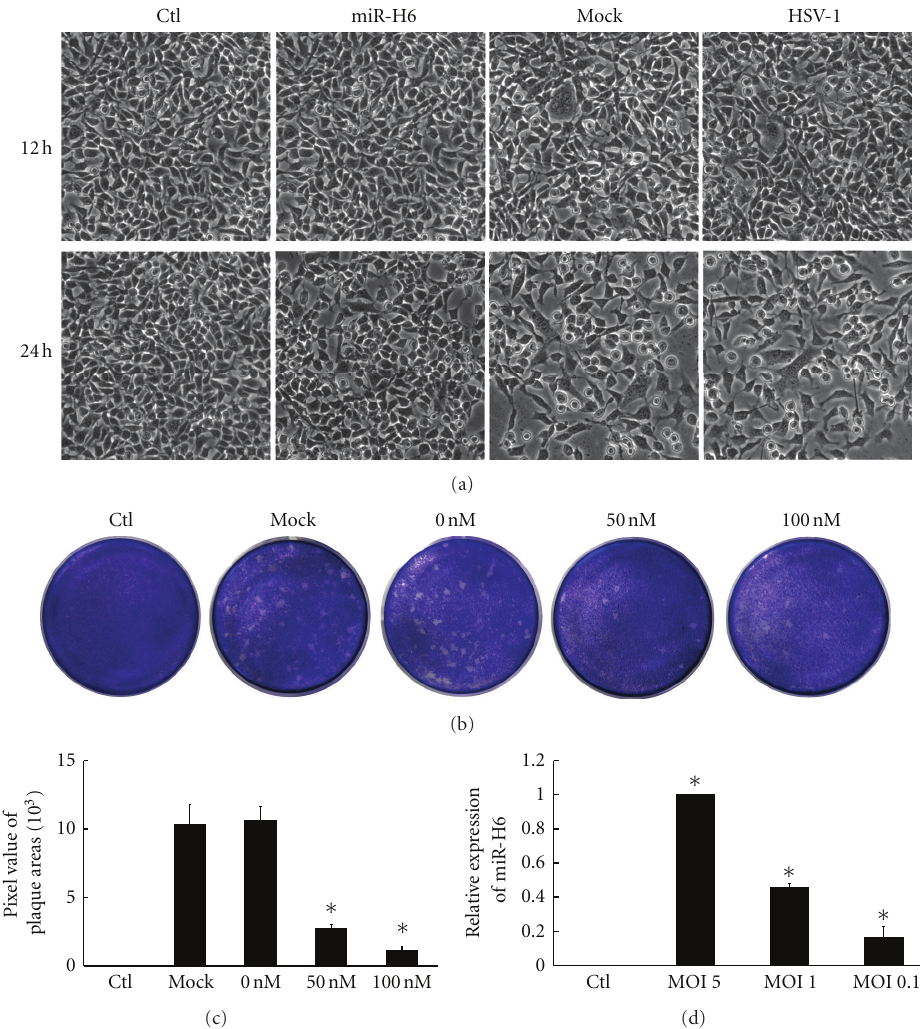
Figure 1: miR-H6 e ff ects on cell changes and viral replication in HSV-1-infected HCE cells. HCE cells were transfected miR-H6 mimics and mock, followed by infection with MOI 0.1 of HSV-1 24 h posttransfection. (a) The cellular morphological changes were imaged at 12 h and 24h postinfection. CPE clearly increased, and many multinucleated giant cells could be seen in the cells treated with mock RNA and cells untreated with small RNA; fewer CPE and giant multinucleated cells could be seen in cells transfected with miR-H6 mimics. (b, c) Plaque assay showed that treatment with miR-H6 decreased the plaque sizes and numbers and had a statistically significant di ff erence ( P < 0 . 05). Cells were treated with miR-H6 mimics (0, 50, 100nM) and mock RNA (mock) or without small RNA (HSV-1). The control group (Ctl) consisted of cells without virus infection and small RNA treatment. (d) Real-time PCR determined miR-H6 expression in pooled HSV-1- infected HCE cells, and miR-H6 levels were changed in a viral-titer-dependent manner ( ∗ P < 0 . 01, one-way ANOVA, among MOI 0.1, 1, and